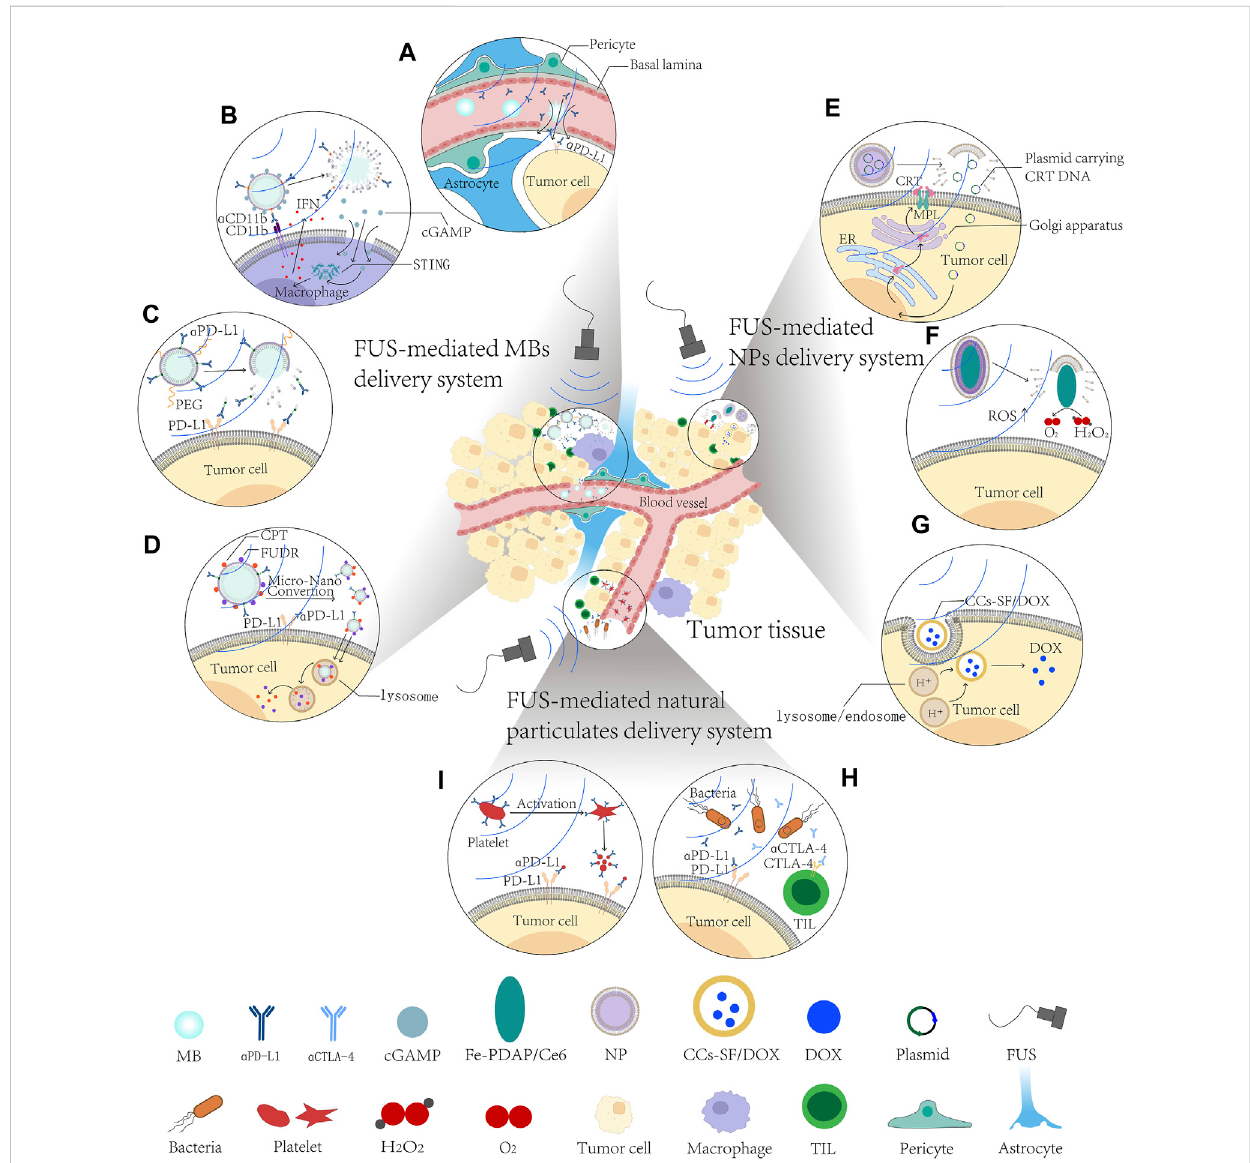
Schematic diagram of FUS-mediated small-molecule delivery systems in solid tumor treatment. (A – D) FUS-mediated microbubble delivery system improves the therapeutic effects and diminishes side effects of ICB. (A) FUS-MBs delivery system disrupt BBB/BTB to enhance penetration and distribution of α PD1 antibody. (B) FUS-mediated cGAMP loading ncMBs targeting macrophages speci fi cally activate cGAS-STING pathway. (C) FUS- mediated IMC delivery to alleviate their immunogenicity. (D) FUS-mediated α PFC MBs to reach higher tumor cell uptake and deeper tumor penetration. (E – G) FUS-mediated nanoparticles delivery system synergizes with ICB in solid tumors. (E) FUS-mediated CRT-NPs upregulate CRT expressionandinduceICDintumorcells. (F) FUS-mediatedMFCtargetingTMEtostimulatereactiveoxygenspecies(ROS)production. (G) FUS-mediated CCs-SF/DOX NPs prevent premature release and increase intracellular n fl ux of drug. (H, I) FUS-mediated natural particulate delivery targets ICs in solid tumors. (H) FUS-mediated engineered platelets effectively target incompletely ablated tumor cells and release α PD-L1 antibody. (I) FUS-mediated therapeutic bacteria home to, and engraft in, tumors to chronically release α PD-L1 and α CTLA-4. α CTLA-4, anti-CTLA-4 antibody; α PD-L1, anti-PD- L1 antibody; CCs-SF/DOX, silk fi broin-modi fi ed doxorubicin preloaded calcium carbonates; cGAMP, cyclic GMP-AMP; CPT, camptothecin; CRT, calreticulin; ER, endoplasmic reticulum;FUDR, fl oxuridine; FUS, focused ultrasound; IFN, interferon; MBs, microbubbles; MPL, thrombopoietin receptor; NPs, nanoparticles; PEG, polyethylene glycol; ROS, reactive oxygen species; STING, stimulator of interferon genes; TIL, tumor in fi ltrating